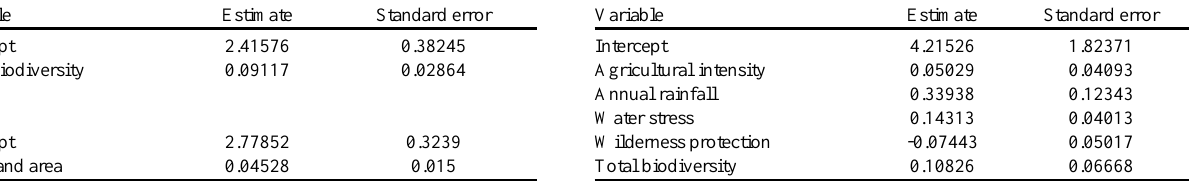
Table 3 . A comparison of support for the top 10 models of social-ecological factors and the proportion of endangered mammals in 100 different countries. Models were ranked by